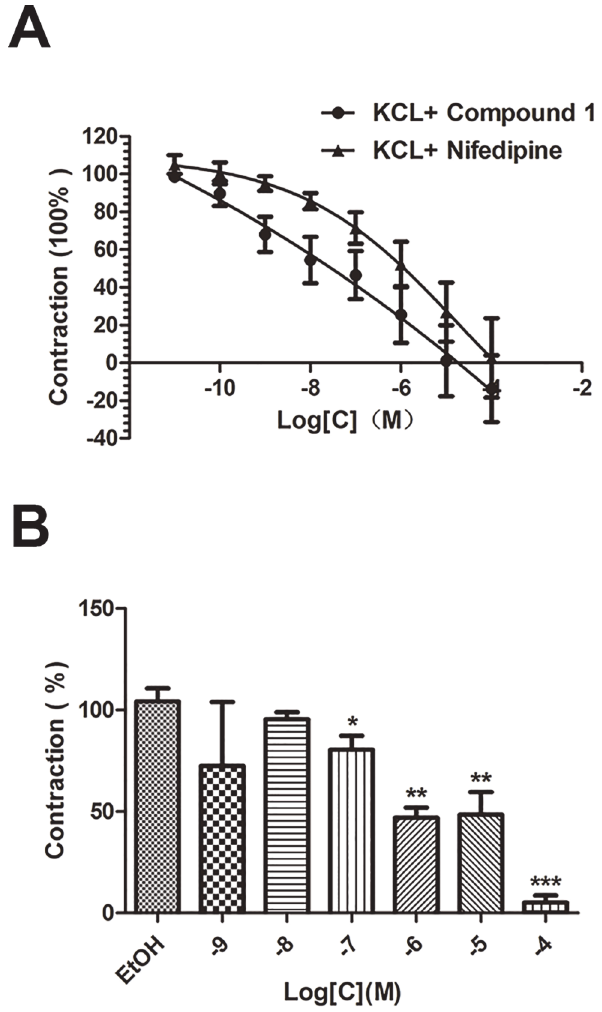
Fig 6. Role of calcium channel in compound 1-induced relaxation. A. Comparison of compound 1 and nifedipine on KCl-activated (80mM) contraction in the endothelium-denuded rings. B. Role of the PE-induced sarcoplasmic reticulum calcium release. Data are showed as mean ± S.E.M., n = 6, * P < 0.05, ** P < 0.01, *** P <